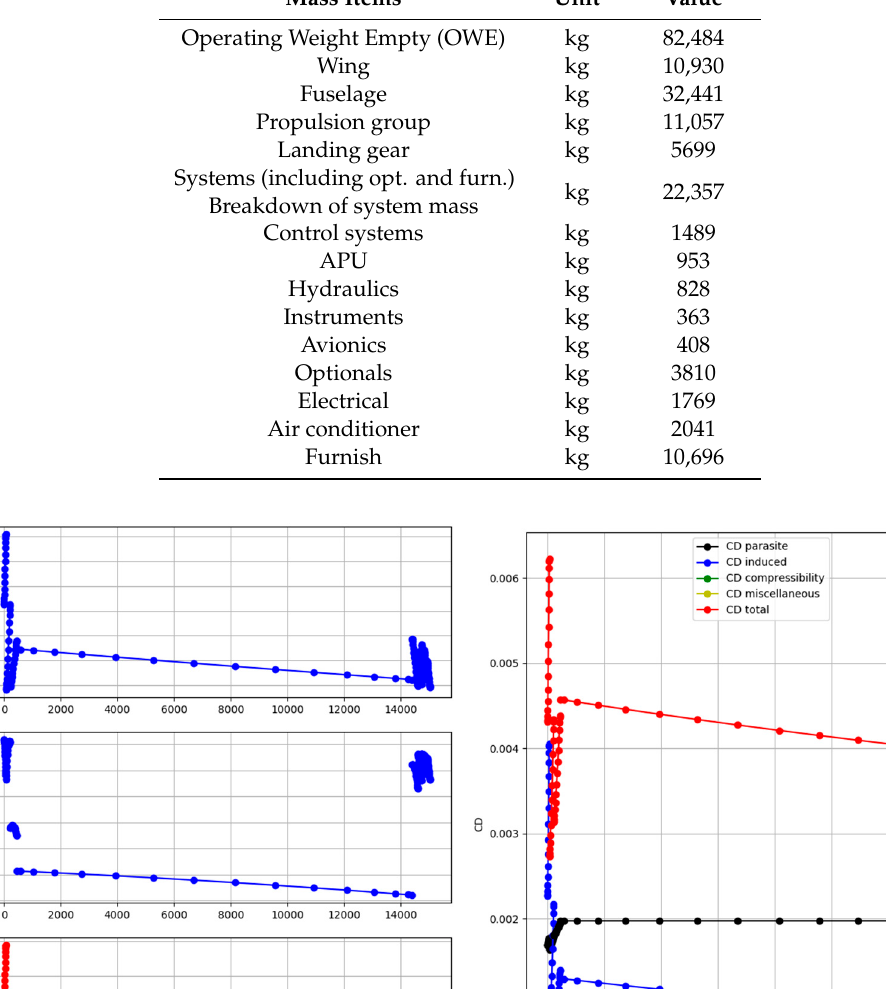
Figure A4. Aerodynamic performance of SE²A-LR.